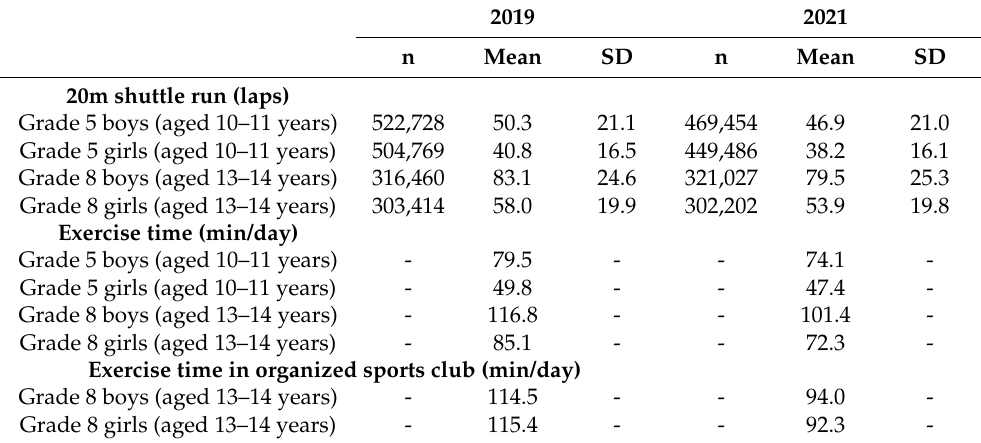
Figure 1. Cumulative newly confirmed cases per 100,000 people at various prefectures. Table 1. The 20 m shuttle run performances and their corresponding exercise times in 2019 and 2021.